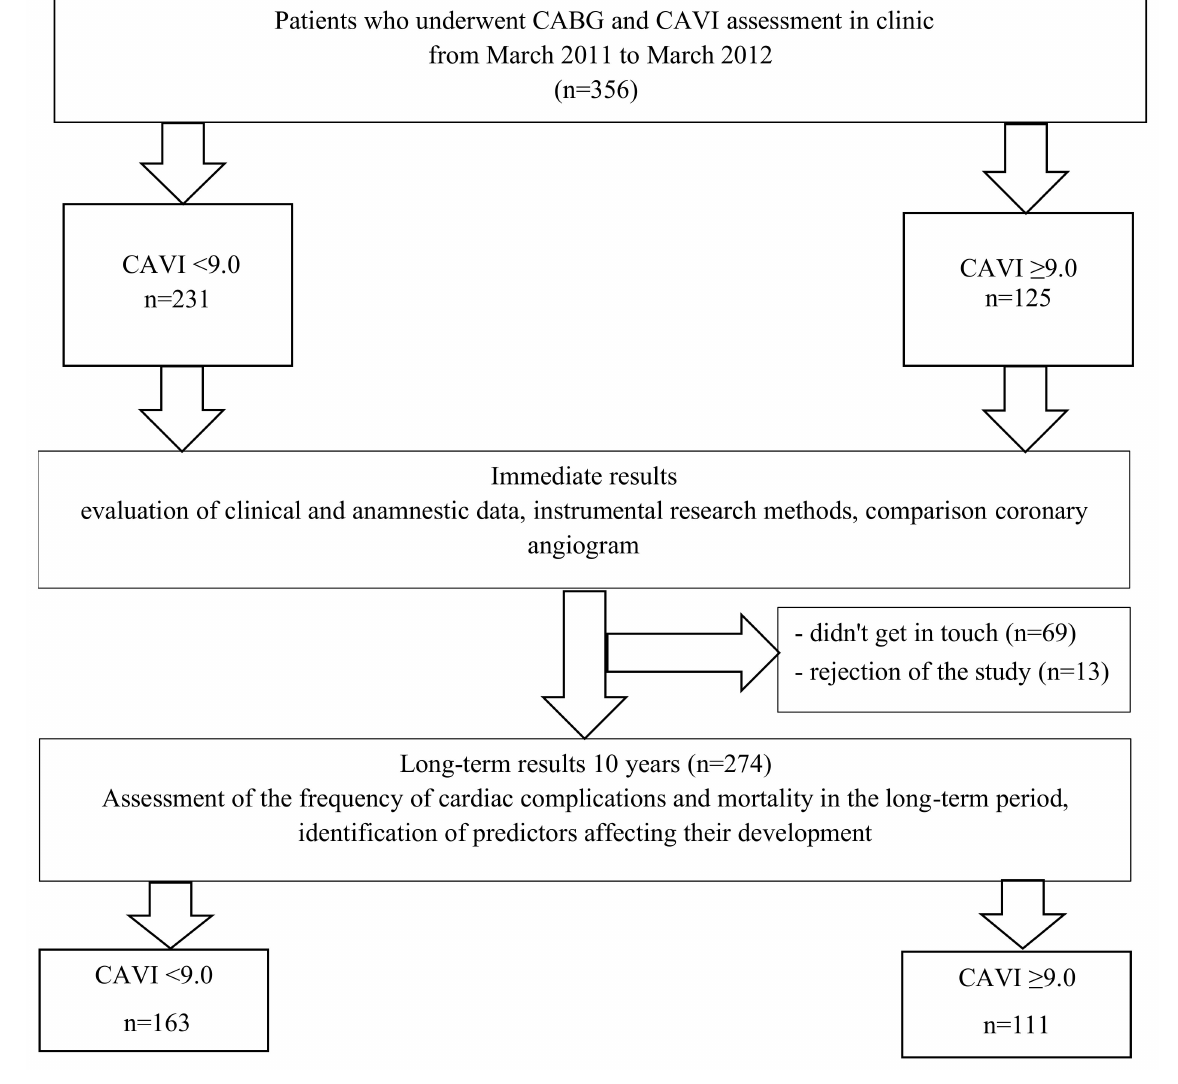
Figure 1. Flowchart of patient selection. CABG—coronary artery bypass surgery, CAVI—cardio-ankle vascular